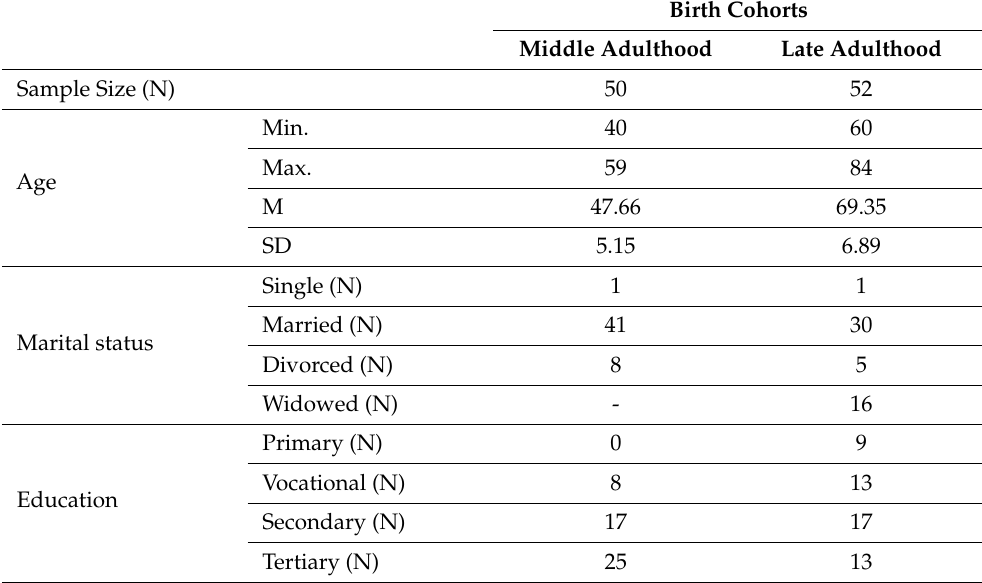
Table 1. Characteristics of research